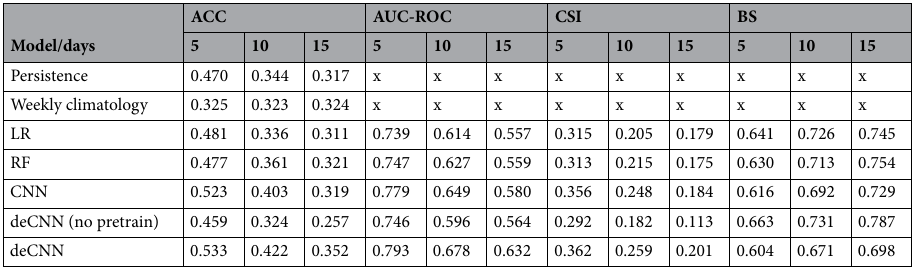
Table 1. Performance metrics for all evaluated models for the four North Atlantic-European circulation regimes for daily samples between 2011 and 2018 relative to ERA5. Days refer to forecast lead time. Best models are highlighted in bold. Cells with “x” denotes unavailable values due to not being probabilistic